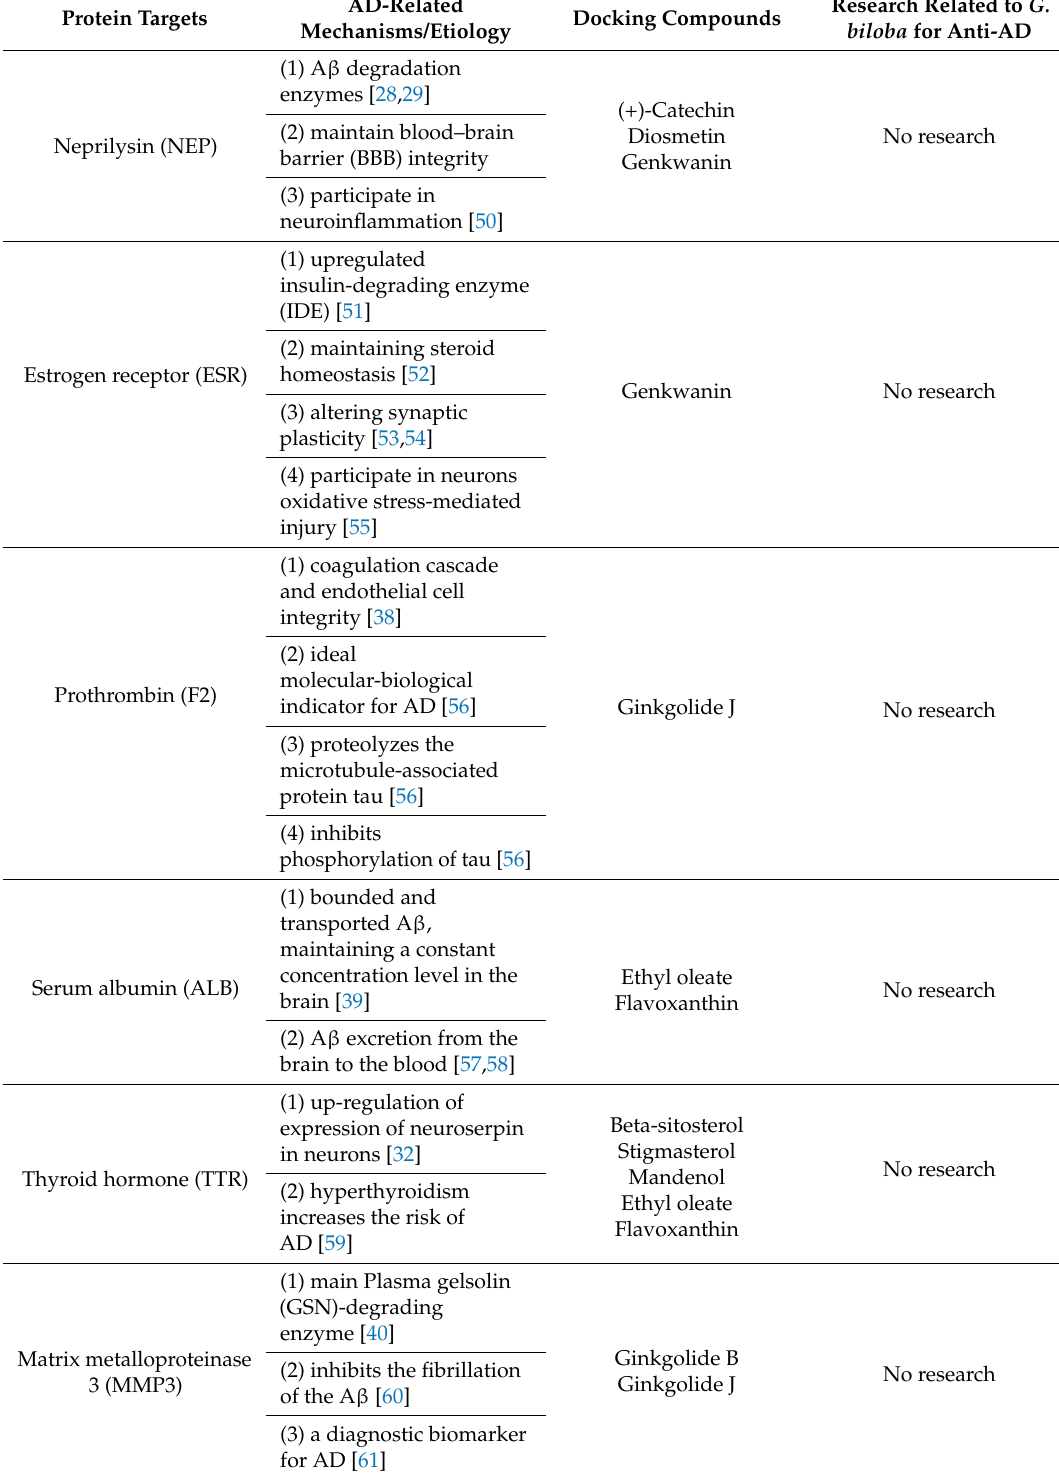
Table 3. The mechanisms of 6 putative protein targets related to AD and the current status of research on G. biloba